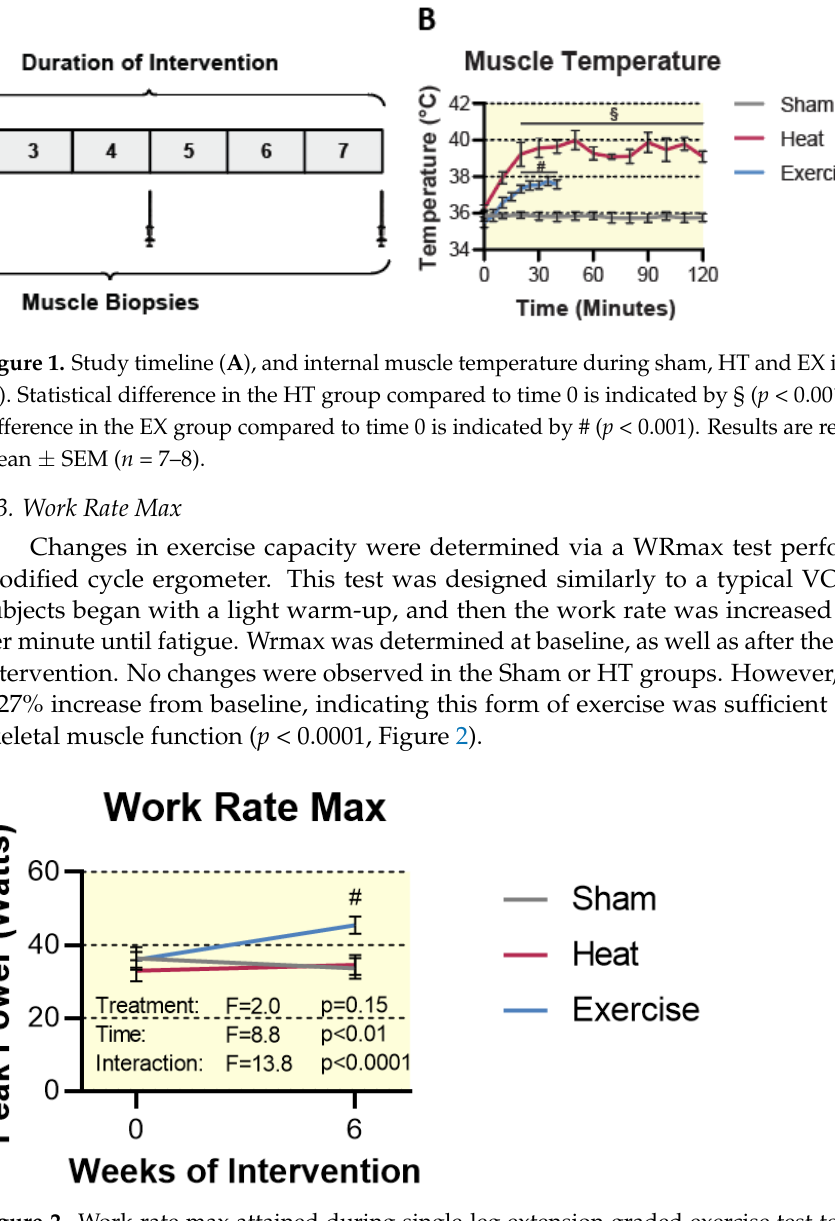
Figure 2. Work rate max attained during single-leg extension graded exercise test to exhaustion. Statistical difference in the EX group compared to time 0 is indicated by # ( p <0.0001). Results are represented as mean ± SEM ( n = 11–12).